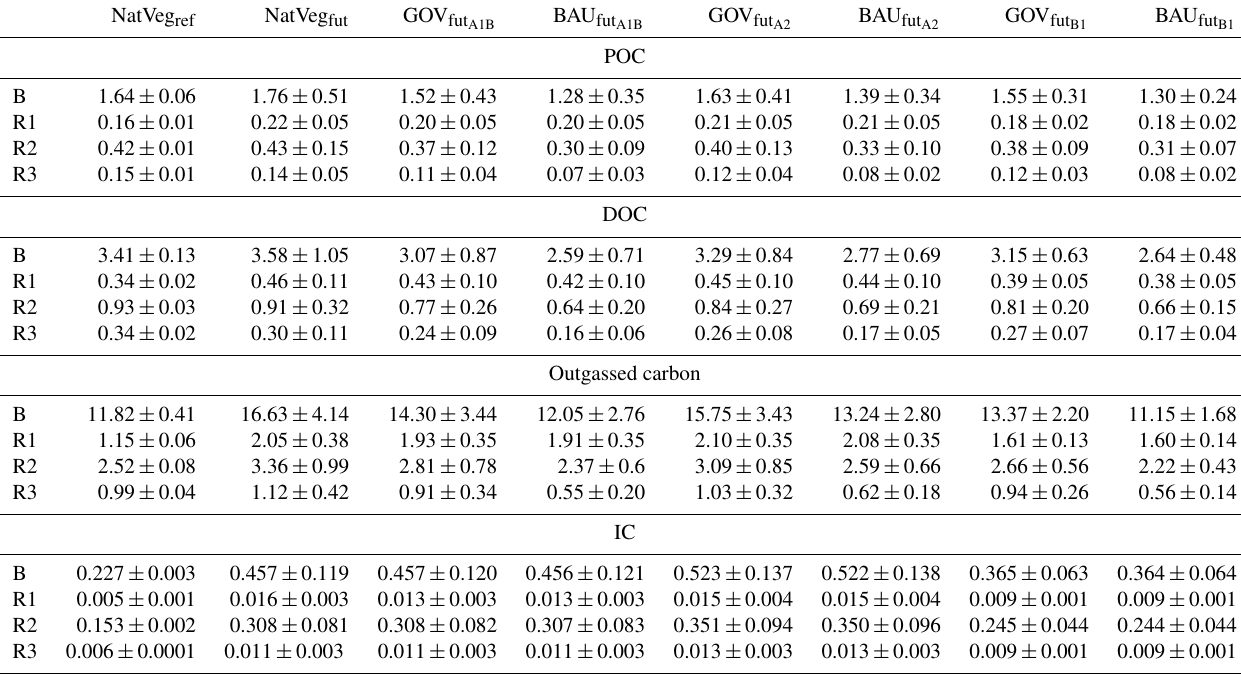
Table 2. Basin-wide (B) and region-wide (R1–R3) amount of carbon in POC and DOC, outgassed carbon and IC (10 12 gmonth − 1 ) averaged over 30 years and five climate models.